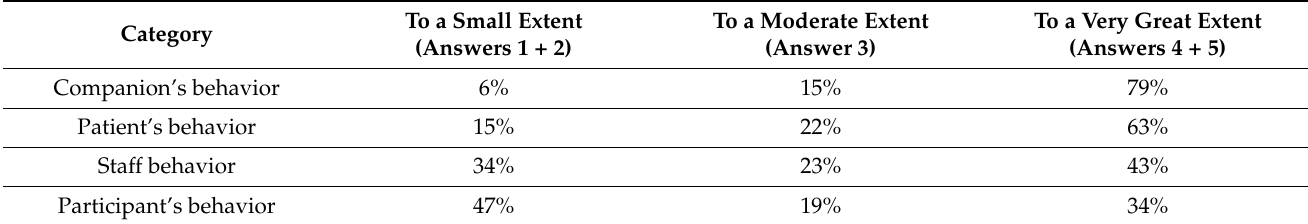
Table 3. Contribution to the violent incidents in the hospital.